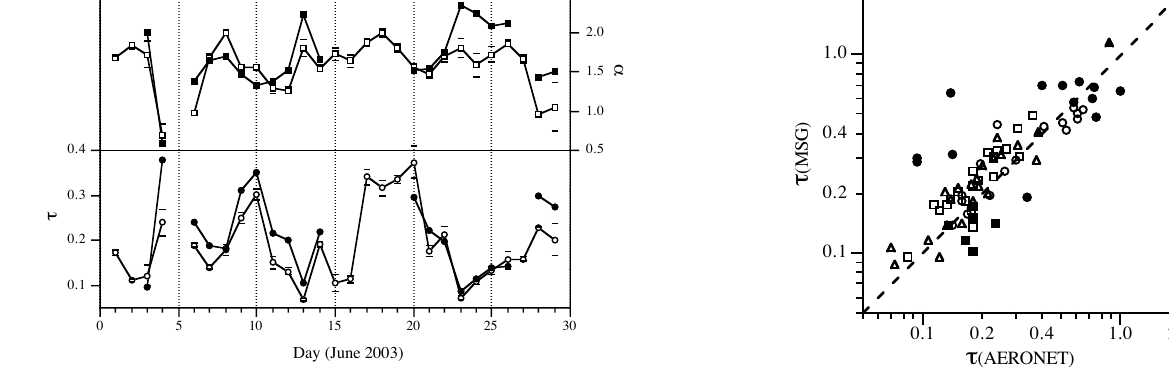
Fig. 4. Comparison of the 77 aerosol optical thicknesses at 0.55 µ m retrieved from coincident MSG and AERONET measurements. Open and filled symbols are respectively for Mediterranean (56 measurements; circles for Erdemli, squares for Nes Ziona and tri- angles for Forth Crete) and Atlantic (21 measurements; circles for Dahkla, squares for Azores and triangles for Sal island) stations (see Table 1). Note that logarithmic axes have been used to evidence small values of τ . The slope of the linear regression performed on all data is 1.0, with a correlation coefficient of